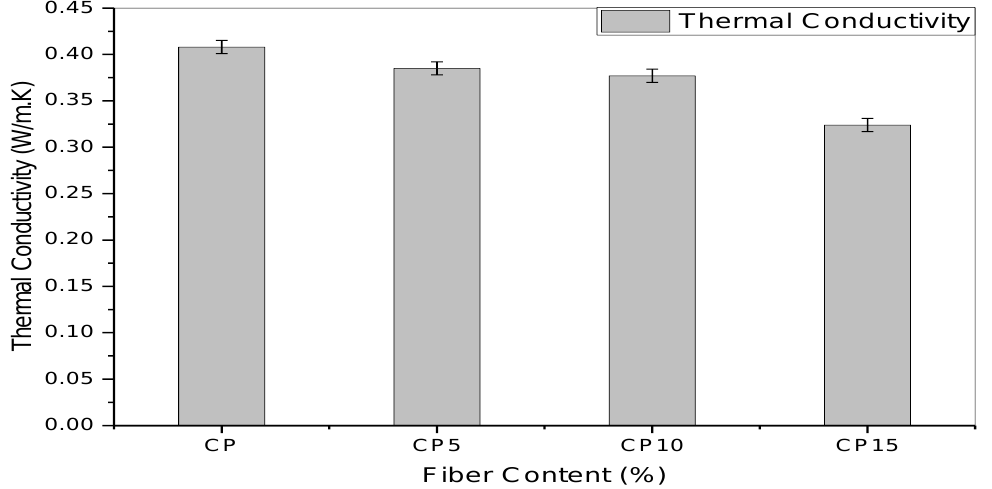
Figure 12. Thermal conductivity and wheat straw percentage relation in the